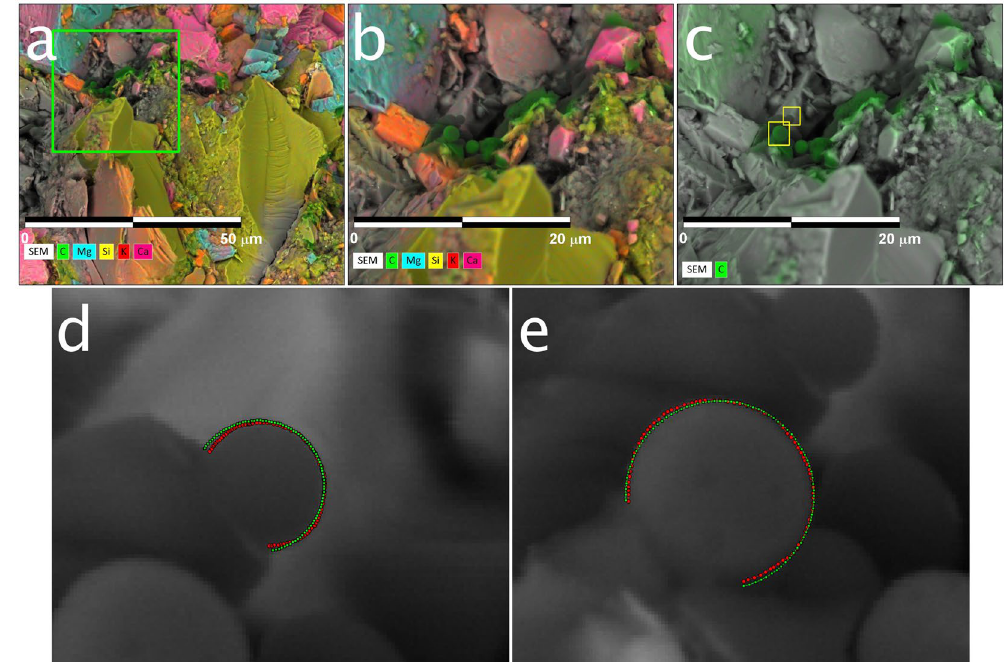
Figure 5. ( a – c ) Elemental maps superimposed on a back-scatter electron image of the cryogenically-frozen middle Bakken sample after it had been submersed in formation oil. The elemental map in ( a ) is zoomed in ( b ) (green box, 30 µ m wide) to reveal oil micro-droplets (green) in the intergranular space. In ( c ), only the element carbon is shown, emphasizing the location of the oil droplets in the intergranular space. ( d , e ) The oil droplets highlighted in the yellow boxes in ( c ) are zoomed in to illustrate the fitting of the parameterized Young-Laplace Equation (green dotted line) to the extracted droplet profile (red dotted line). The micro-droplet in ( d ) has a measured drop height and width of 671 nm and of 871 nm, respectively, and calculated right and left contact angles of 113° and 109°, respectively. The micro-droplet in ( e ) has a measured drop height and width of 1.3 µ m and of 1.2 µ m, respectively, and calculated right and left contact angles of 128° and 130°,